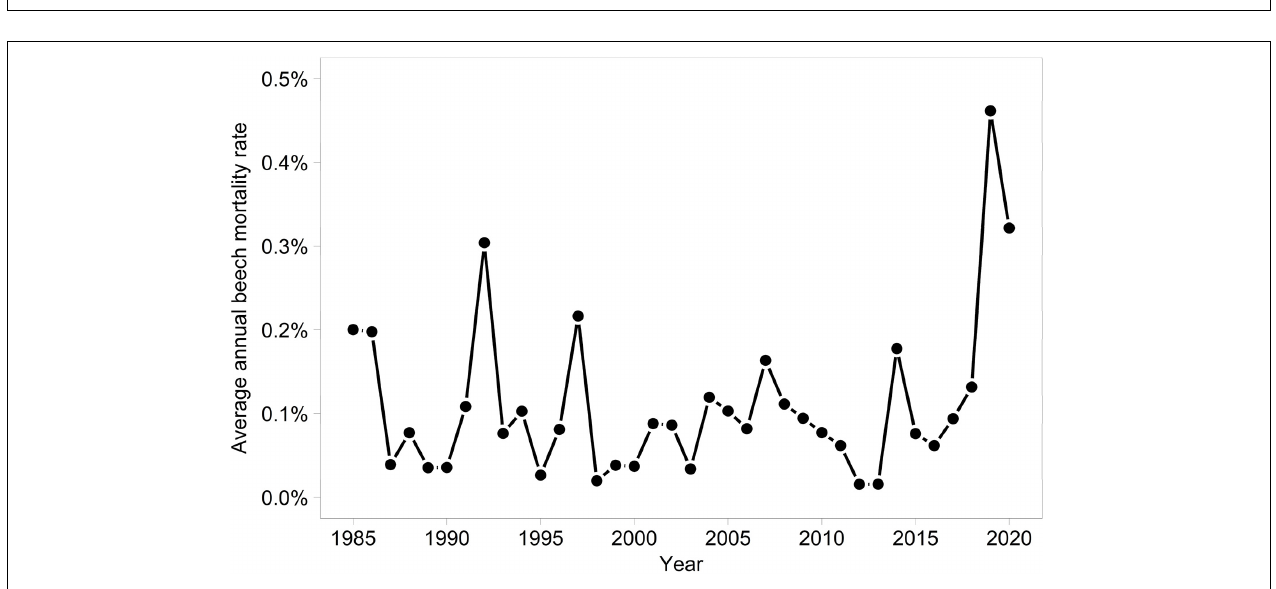
FIGURE 1 | Proportion of Fagus sylvatica with a crown transparency of > 60%.